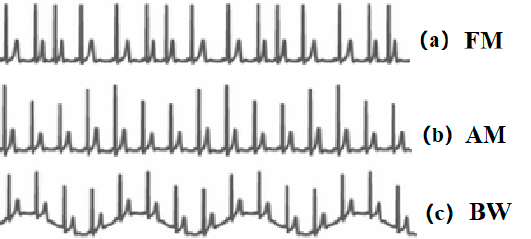
Figure 1. ( a ) Respiratory Sinus Arrhythmia (RSA) induced frequency modulation (FM). ( b ) Electrical axis rotation caused amplitude modulation (AM). ( c ) Baseline wander (BW) caused by chest movement.